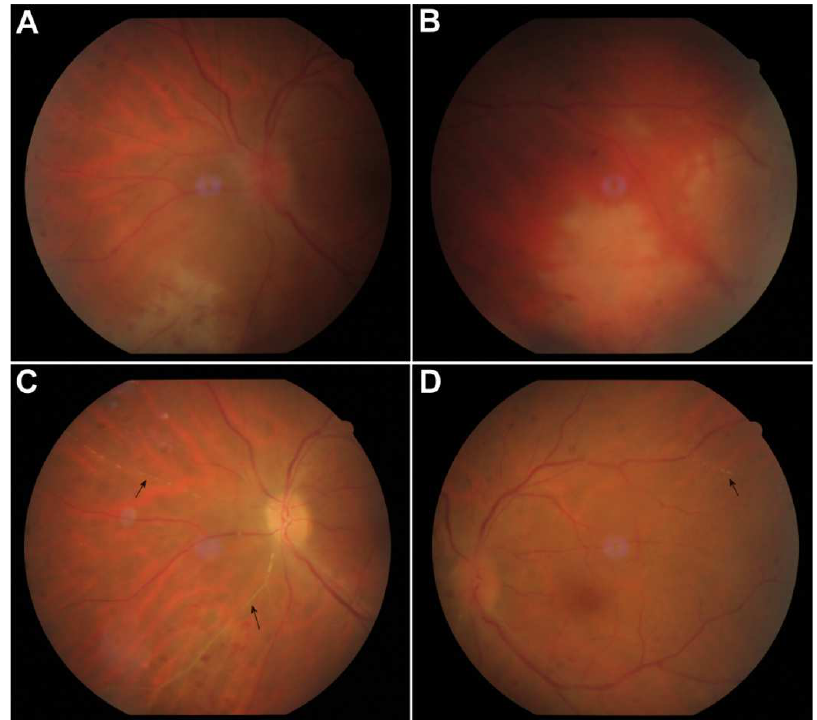
Figure 1. Color fundus photo of the left eye at presentation showing vitreous inflammation, optic nerve edema and peripheral areas of retinal necrosis with neighboring vasculitis in the temporal, inferior and nasal quadrants ( A , B ). Two weeks after the initiation of treatment, vitritis decreased and Kyrieleis plaques were seen in nasal and temporal retinal arteries, as yellowish plaques that did not extend beyond the vessel walls (( C , D ), arrows). Table 1. Patient’s clinical